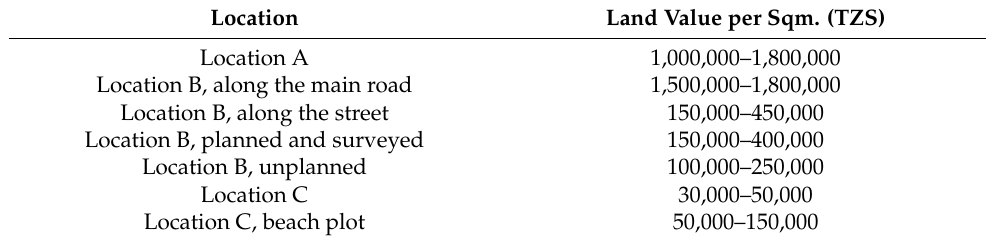
Table 2. Current land value table in